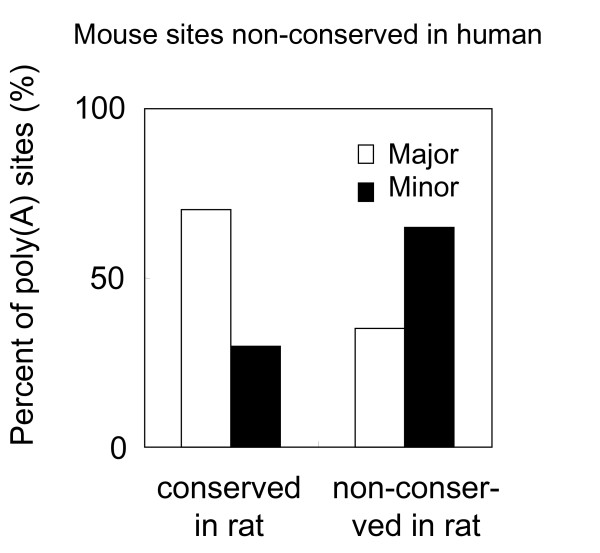
Rat conservation of mouse non-conserved sites. Left: ratio of mouse polyadenylation sites that are non-conserved in the human genome and are conserved in rat. Right: ratio of mouse polyadenylation sites that are non-conserved in the human genome and are non-conserved in rat. Ratios are given for minor (RE<0.5) and major (RE>0.5) sites.